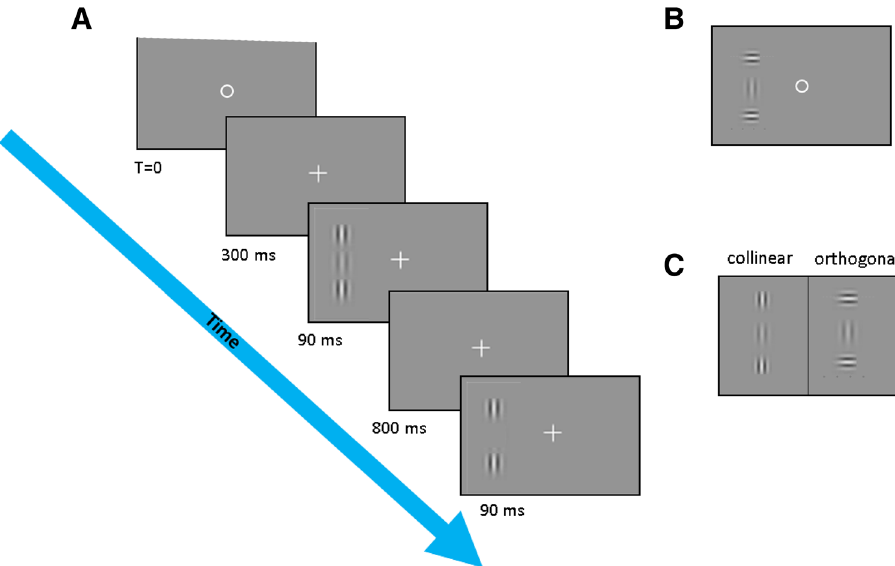
Figure 6. Stimuli. ( A ) Stimuli (collinear) presented at 4° in the periphery. The circle and the crosses indicates the fixation point at the fovea. The temporal sequence of the presentation from the initial trial until it presented either at the left or the right side (as presented here) on the periphery. ( B ) Example of orthogonal stimuli presented at the left side ( C ) two configurations that used in the study. Collinear (left) and orthogonal